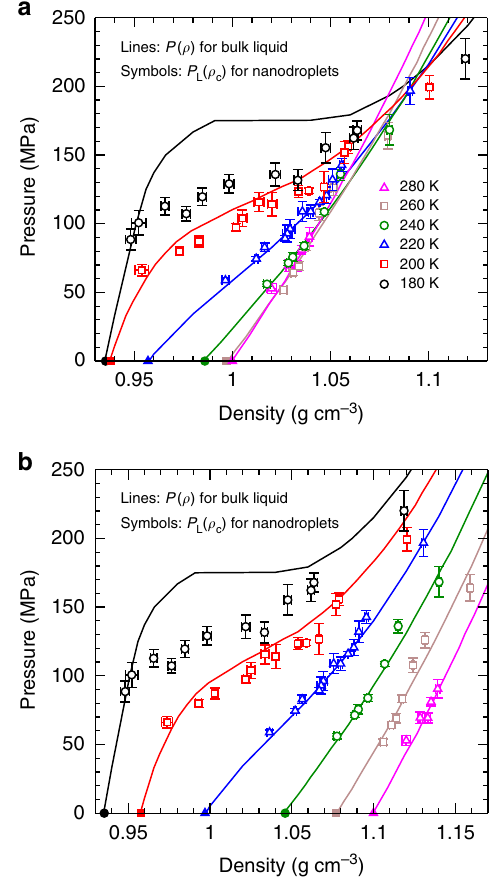
Fig. 3 Equations of state for bulk liquid and nanodroplets of TIP4P/2005. a Isotherms of P ( ρ ) for the bulk liquid (solid lines), taken from the EOS presented in ref. 21 ; and P L ( ρ c ) for water nanodroplets (open symbols). N decreases with increasing density along each isotherm. The fi lled symbols locate the bulk behaviour expected for droplets as R → ∞ and N → ∞ . Lines and symbols of the same colour correspond to the same T . b Same as in a , but to permit easier examination of each isotherm, all data for T = 200 K have been shifted horizontally by 0.02 g cm − 3 ; for 220 K by 0.04 g cm − 3 ; for 240 K by 0.06 g cm − 3 ; for 260 K by 0.08 g cm − 3 ; and for 280 K by 0.10 g cm − 3 . Legend is the same as in a . In both panels, error bars represent one standard deviation of the